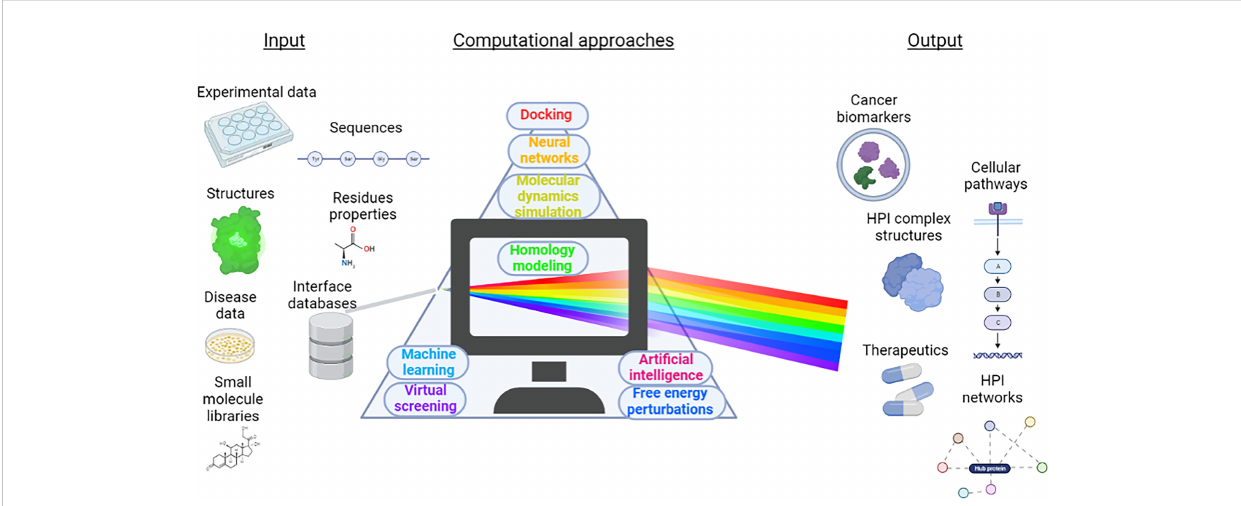
FIGURE 5 A scheme of bene fi ts that can be obtained from computational approaches in HPI-related cancer research. Data such as experimental analysis, available protein structures, available PPI interface databases, amino acid residue properties, small molecule libraries, disease data and amino acid sequences of the proteins of interest provide input. Various computational methods including but not limited to MD simulations, docking, ML, AI, neural networks, free energy perturbations, virtual screening process these data and can identify novel cancer biomarkers, unravel unknown HPI complex structures, produce HPI networks, screen for novel therapeutics and identify cellular pathways that they